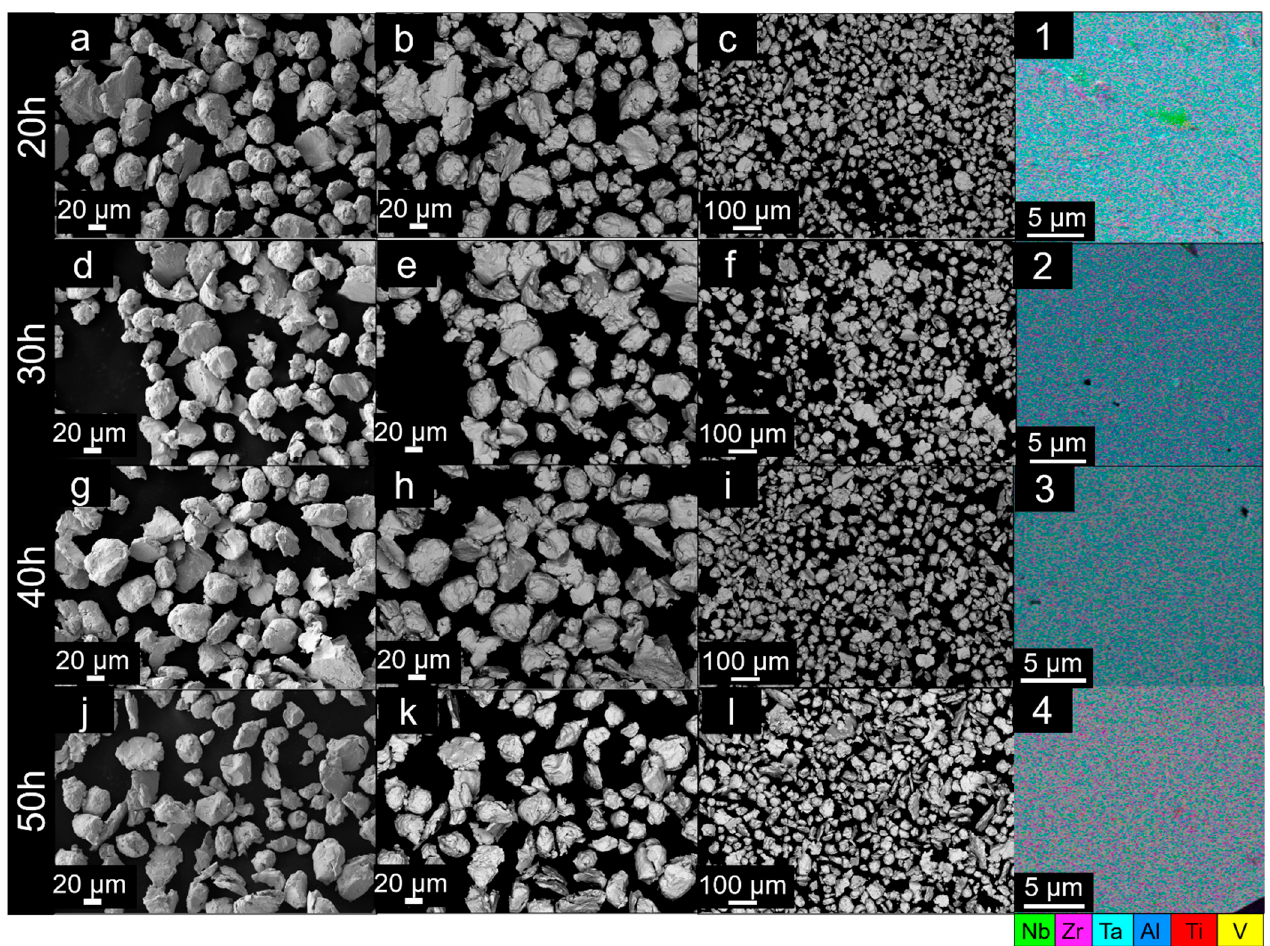
Figure 4. SEM images of Al 0.3 NbTa 0.8 Ti 1.5 V 0.2 Zr powders after different milling times from 20 to 50 h, respectively. The milling times are shown on the left side of each row of images. ( a , d , g , j ) SEM micrographs using SE detector showing powders in detail after each milling from 20 to 50 h, in order. ( b , e , h , k ) Corresponding SEM images using BSE detector showing powders in detail after each milling. ( c , f , i , l ) SEM images using BSE mode to exhibit an overview of the powders in lower magnifications. ( 1 – 4 ) EDS maps taken from the particle cross-section of each powder milled from 20 to 50 h, respectively.